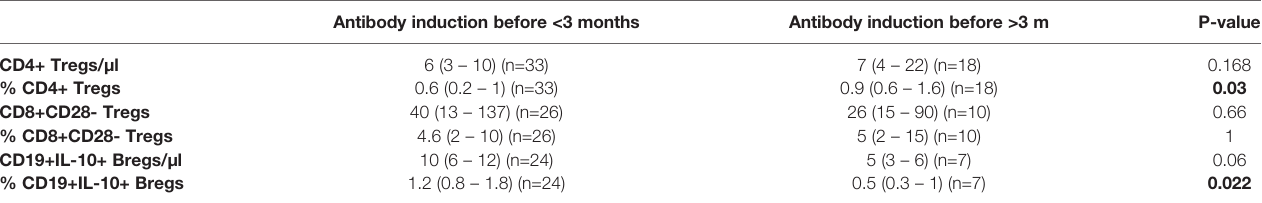
TABLE 5 | Comparison of the absolute and relative counts of CD4+CD25+CD127-Foxp3+ Tregs, CD8+CD28- Tregs, and IL-10+ Bregs in early Tx recipients in whom antibody induction dates back ≤ 3 months vs. > 3 months prior to blood